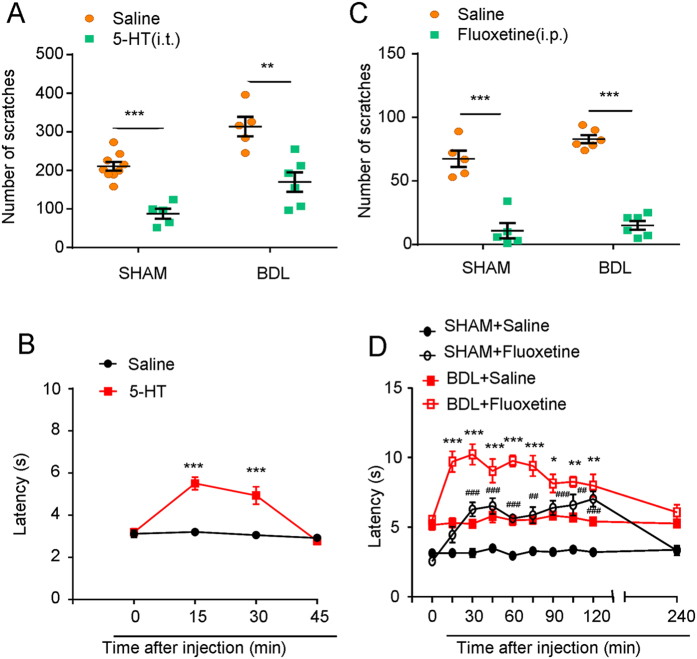
Enhanced 5-HT level in CNS inhibited itch and induced antinociception in sham and BDL rats.(A) Intrathecal (i.t.) injection of 5-HT (1 μg) significantly suppressed scratching induced by i.d. injection of 5-HT (200 μg) into the nape of the neck in sham and BDL rats (n = 5–9 per group). (B) I.t. injection of 5-HT (1 μg) increased the latency of tail-flick response to 52 °C hot water in naïve rats (n = 6–8 per group). (C) Intraperitoneal (i.p.) injection of 5-HT reuptake inhibitor fluoxetine (10 mg/kg) significantly suppressed scratching induced by i.d. injection of 5-HT (200 μg) into the cheek of sham and BDL rats (n = 6–8 for each group) (**P < 0.01, ***P < 0.001 vs. saline values and analyzed by Student’s t-test or two-way AVOVA following Bonferroni post hoc test). (D) I.p. injection of 5-HT reuptake inhibitor fluoxetine (10 mg/kg) significantly increased the latency of tail-flick response to 52 °C hot water in sham and BDL rats in a time-dependent manner (n = 6–8 per group) (*P < 0.05; **P < 0.01, ***P < 0.001 vs. saline values from sham rats; ##P < 0.01, ###P < 0.001 vs. saline values from BDL rats and analyzed by two-way AVOVA following Bonferroni post hoc test).